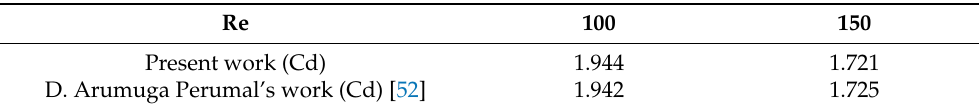
Table 2. Average drag coefficients for elliptical cylindrical bypass flow at different Reynolds numbers, and comparison with previous